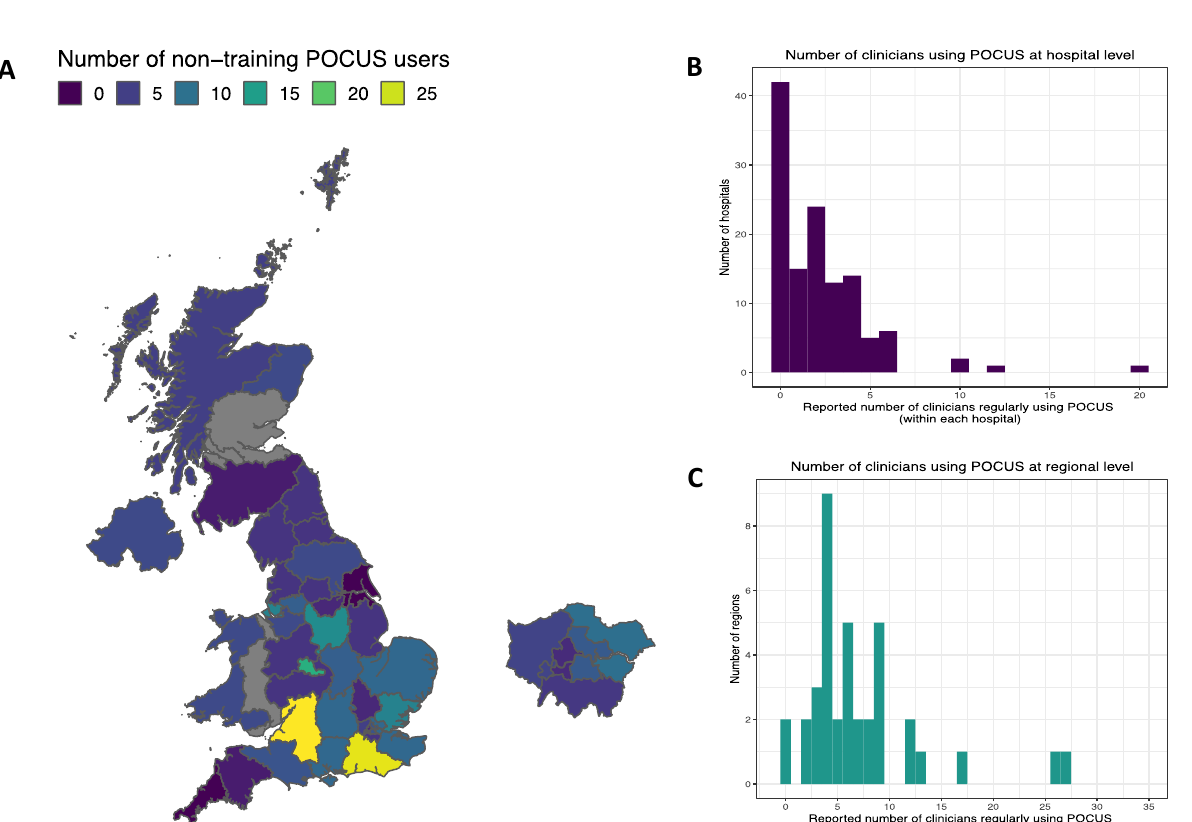
Fig. 3 Geographical variation in the number of non-training grade clinicians that regularly use point of care ultrasound. A Map of demonstrating the number of clinicians within ITL2 boundaries. B Histogram showing counts at the Hospital level C Histogram showing counts at the ITL2 level. *grey no response to =